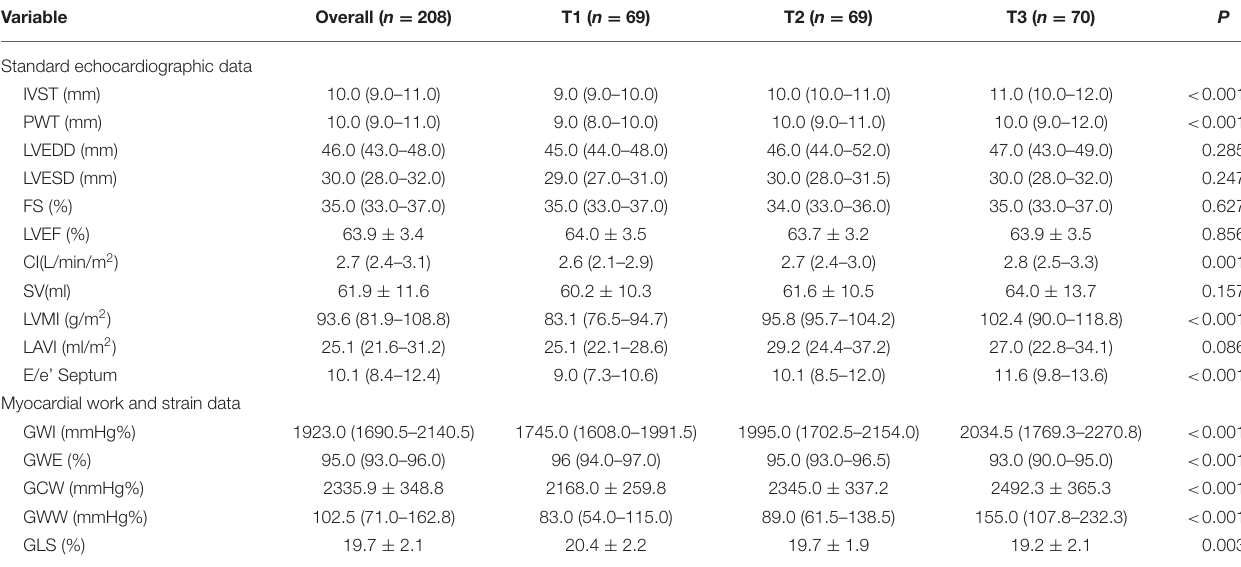
TABLE 2 | Ehocardiographic data in the study population and in tertile groups.